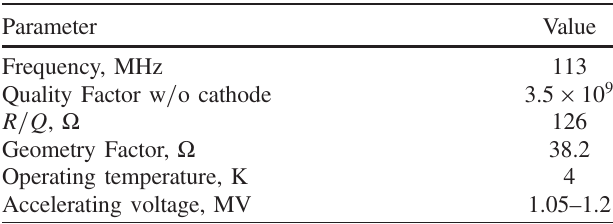
TABLE I. rf parameters of the gun.